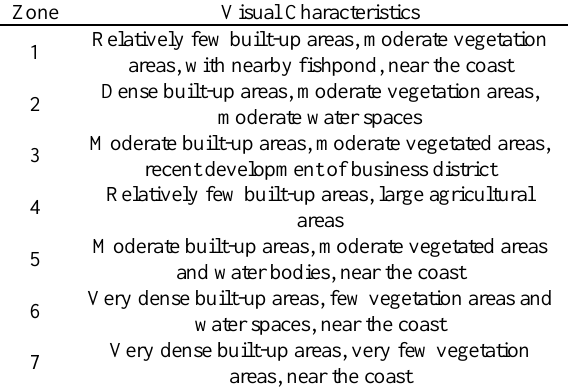
Table 1. Visual description of each surrounding